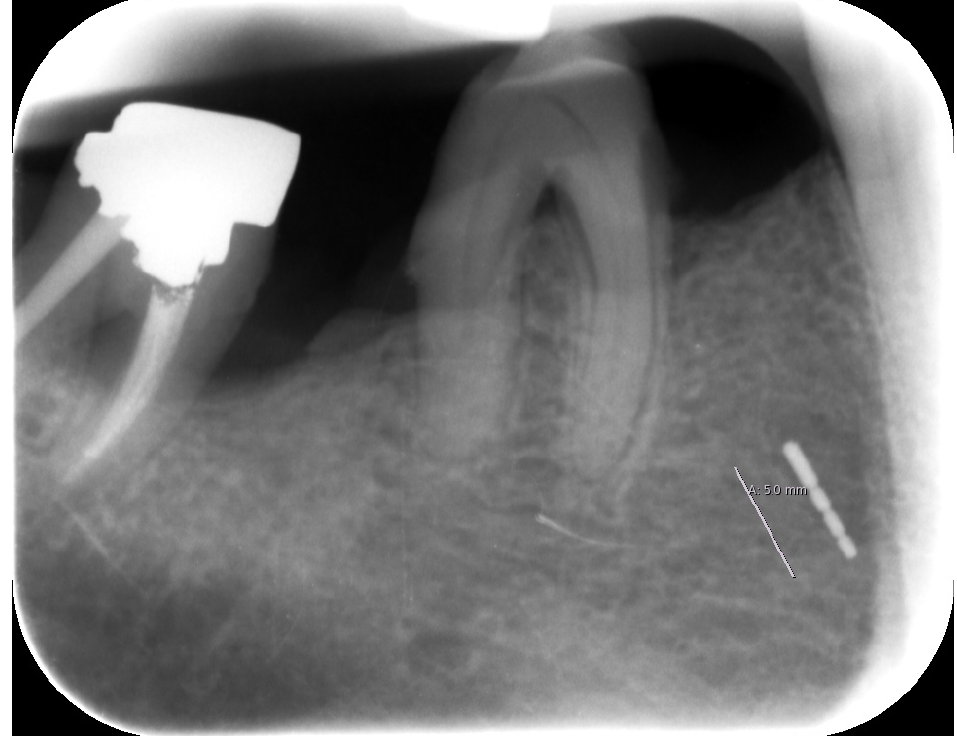
Figure 3. Periapical X-ray with the broken periodontal probe.3. Diagnosis.